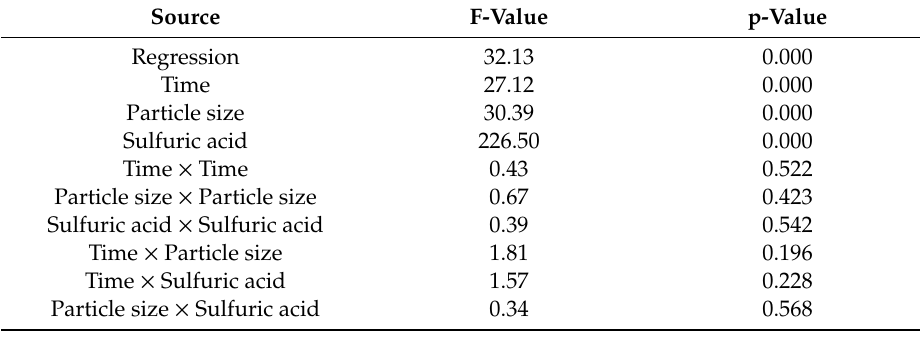
Table 5. ANOVA of the Mn extraction rate.